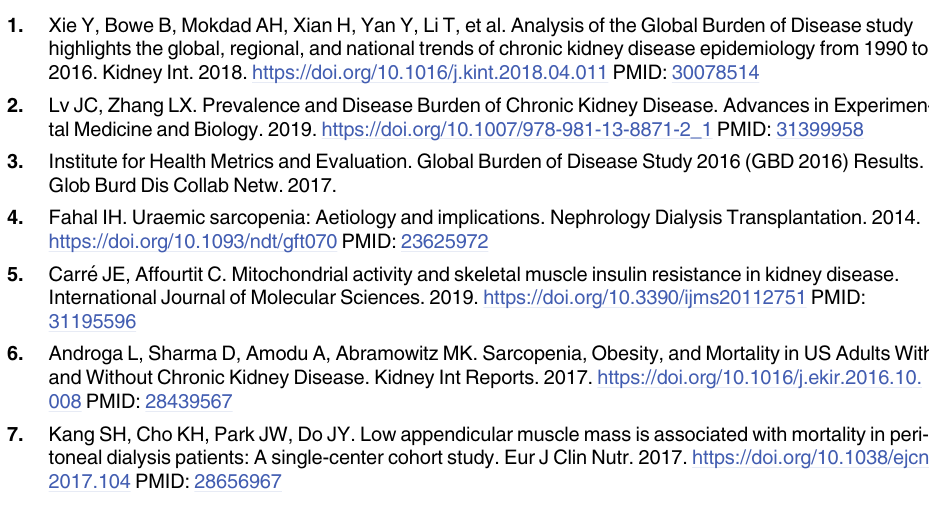
S4 Table. Sensitivity and specificity of bed-side measures/indexes to identify low muscle mass, obesity, sarcopenia and sarcopenic obesity in CKD